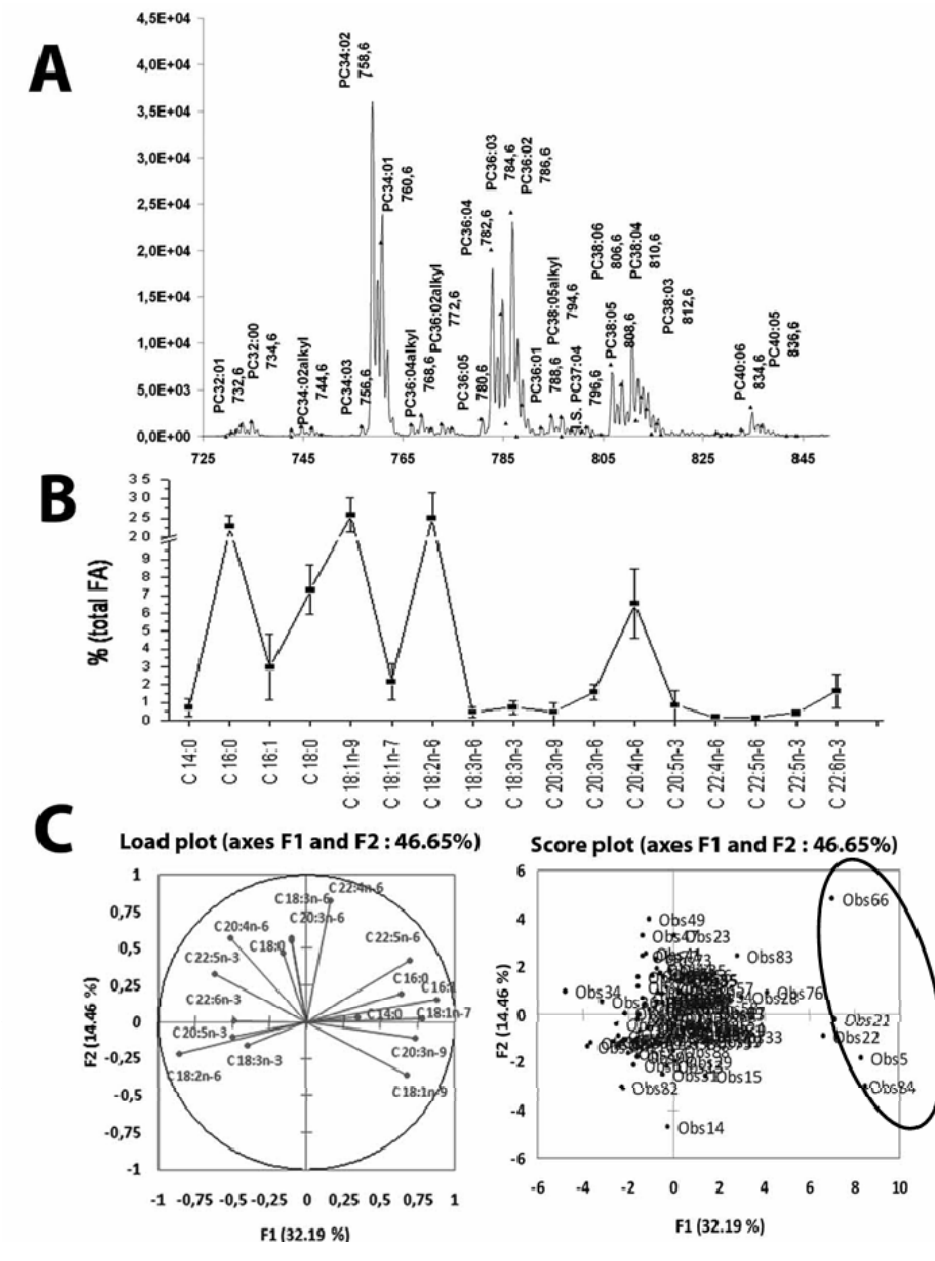
Figure 2. ( A ) Identification of molecular species of phosphatidylcholine from total lipid analysis of serum. ( B ) The distribution of 17 major fatty acids in the total circulating lipidome was obtained by gas chromatography of fatty acid methyl esters prepared by acidic transmethylation. ( C ) Sera from 93 patients (adults and children) were randomly sampled. Four sera (Obs 66, 21, 5 and 84) show an enrichment in fatty acid marking the accelerated de novo lipogenesis; fatty acid 16:1 (palmitoleic), 18:1 ω 7 (vaccenic), 20:3 ω 9 (mead acid) are increased in these patients scored in left part of the biplot. The enrichment is recorded at the expense of the ω -3 essential fatty acid (C 22:6 ω 3 (docosahexaenoic), 20:5 ω 3 (eicosapentaenoic), 22:5 ω 3 (docosapentaenoic acid)) shown “diametrically” opposite in the right part of the biplot. The biplot is obtained by the superimposition of the load plot for the variations of serum fatty acids (the factorial plan F1/F2 represents 46% of the total variations) and the score plot for the 93